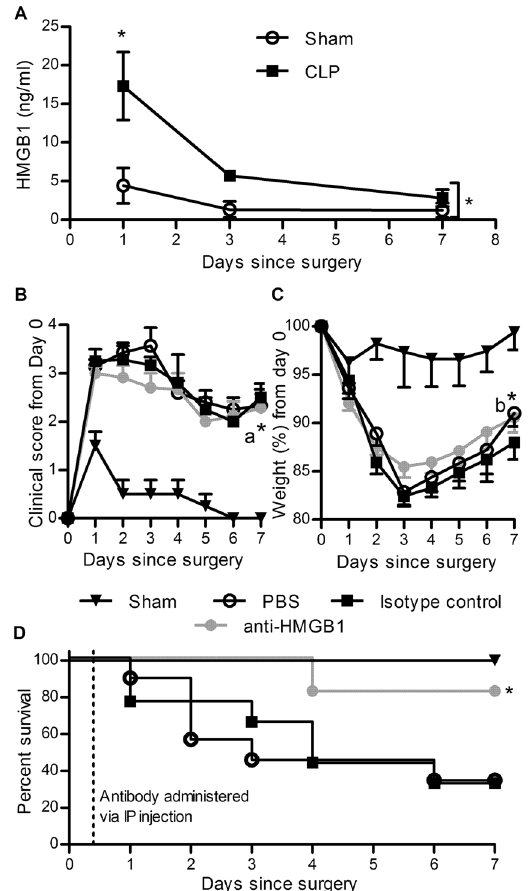
Figure 4. Therapeutic administration of ovine anti-HMGB1 pAb improves survival from CLP sepsis. Mice were subjected to sham-surgery alone (n = 4) or CLP surgery (n = 4) and serum samples from sham or CLP- surgery mice were assayed for HMGB1 via ELISA ( A ). CLP mice (n = 9–11) were administered PBS, control antibody or anti-HMGB1 pAb (25 mg/kg) via IP injection eight hours following surgery. Mice were monitored and euthanised if predetermined humane endpoints were reached. Mean ± SEM of clinical score ( B ) and weight ( C ) and survival curves of the groups ( D ) are depicted. Sequential measurements were compared via two-way ANOVA and survival of anti-HMGB1 treated mice was compared to control groups using the Mantel Cox test with significance denoted as: * P > 0.05, a * P > 0.05 compared against PBS control, b * P > 0.05 compared against control